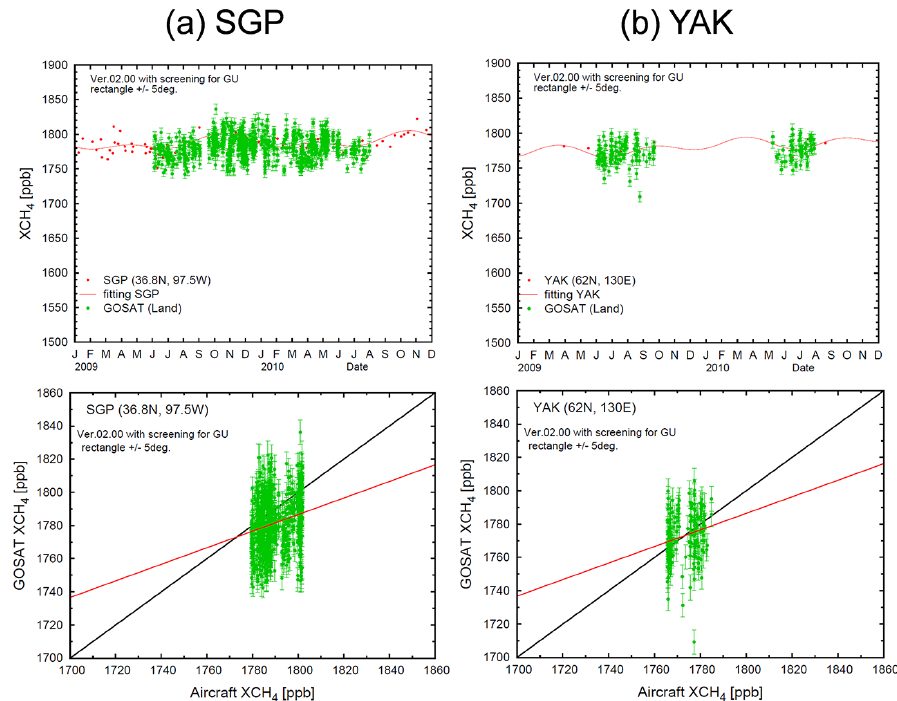
Figure 10. Temporal variations of aircraft-based XCH 4 and GOSAT XCH 4 observed within ± 5 ◦ latitude–longitude boxes centered at the (a) Southern Great Plains (SGP) and (b) Yakutsk (YAK) sites (upper panels) and their scatter diagrams (bottom panels). Green dots indicate GOSAT XCH 4 data over land. Red dots and lines in the upper panels show aircraft-based XCH 4 data and curves fitted to the data, respectively. Red lines in the bottom panels are regression lines statistically significant at the 99% level. The black lines show one-to-one correspondence.